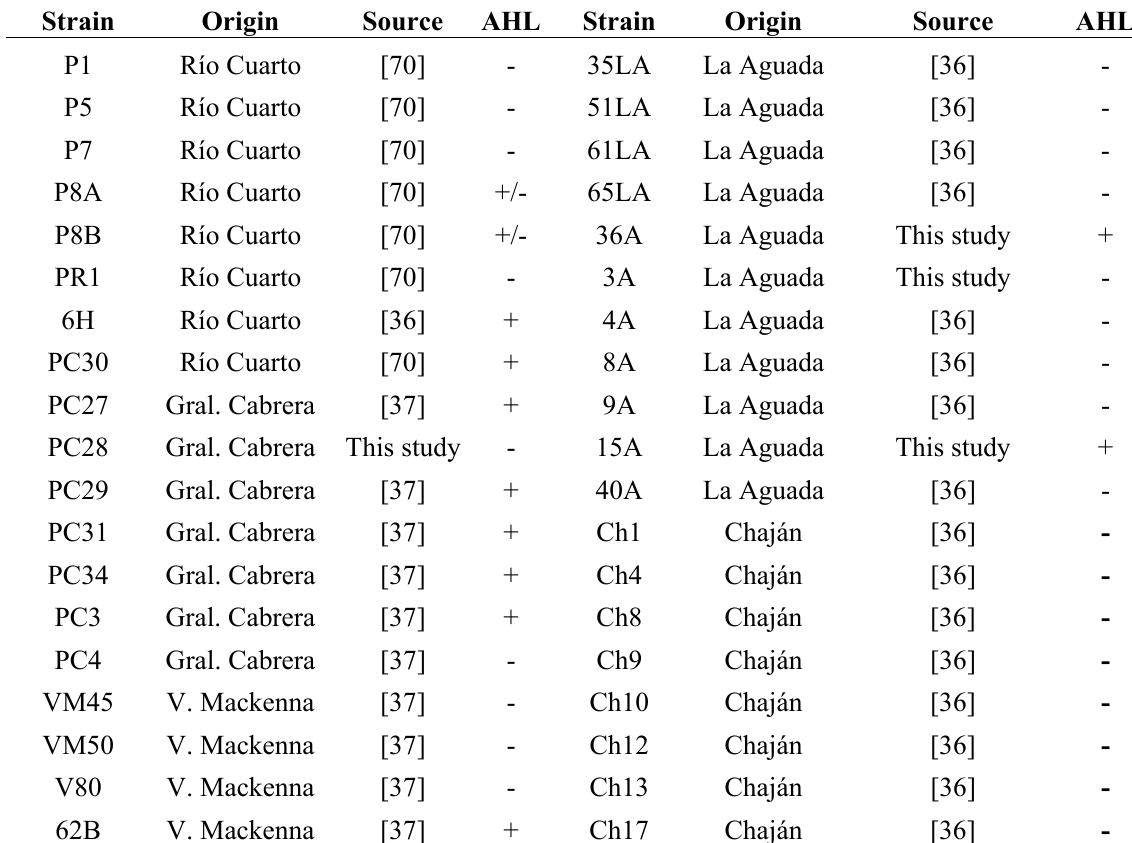
Table A1. Peanut-nodulating rhizobial strains used, and production of AHL-like molecules with long acyl